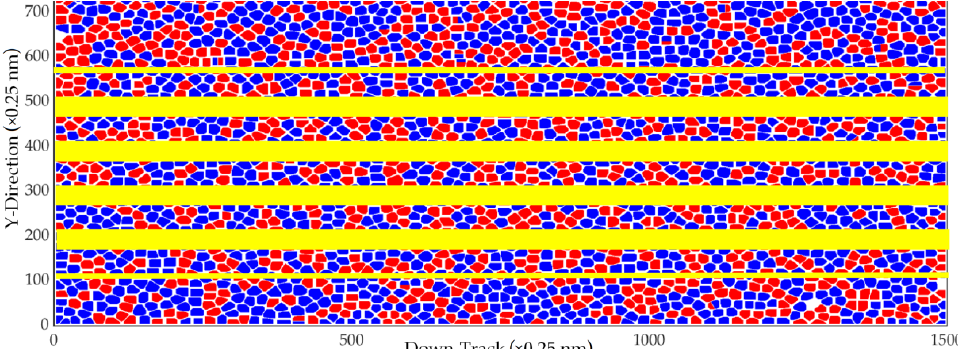
Figure 5. Magnetic footprints at AD of 8.9 Tb/in 2 .